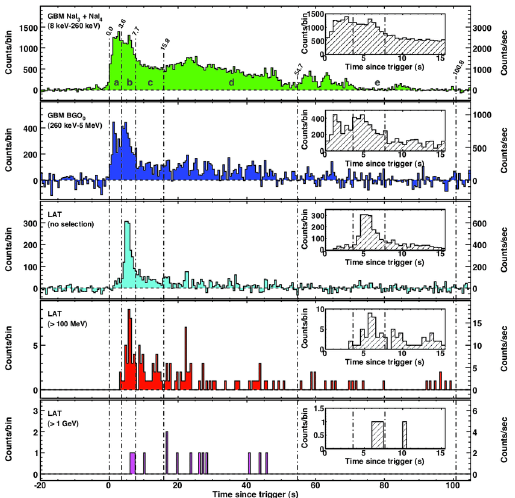
Figure 2. Fermi -GBM and Fermi -LAT combined light curve for GRB 080916C. Reprinted with permis- sion from Ref.